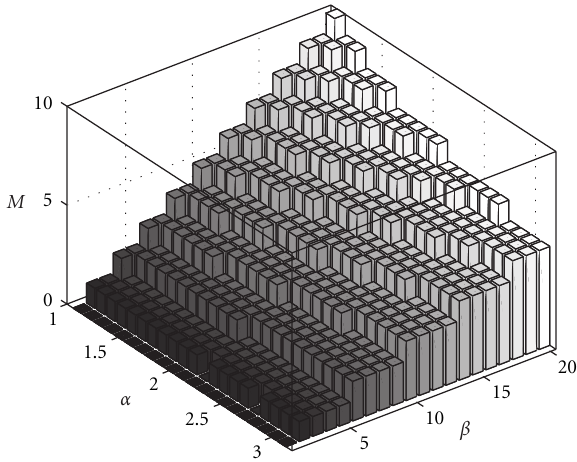
Figure 2: The maximum FEC group size versus α and β